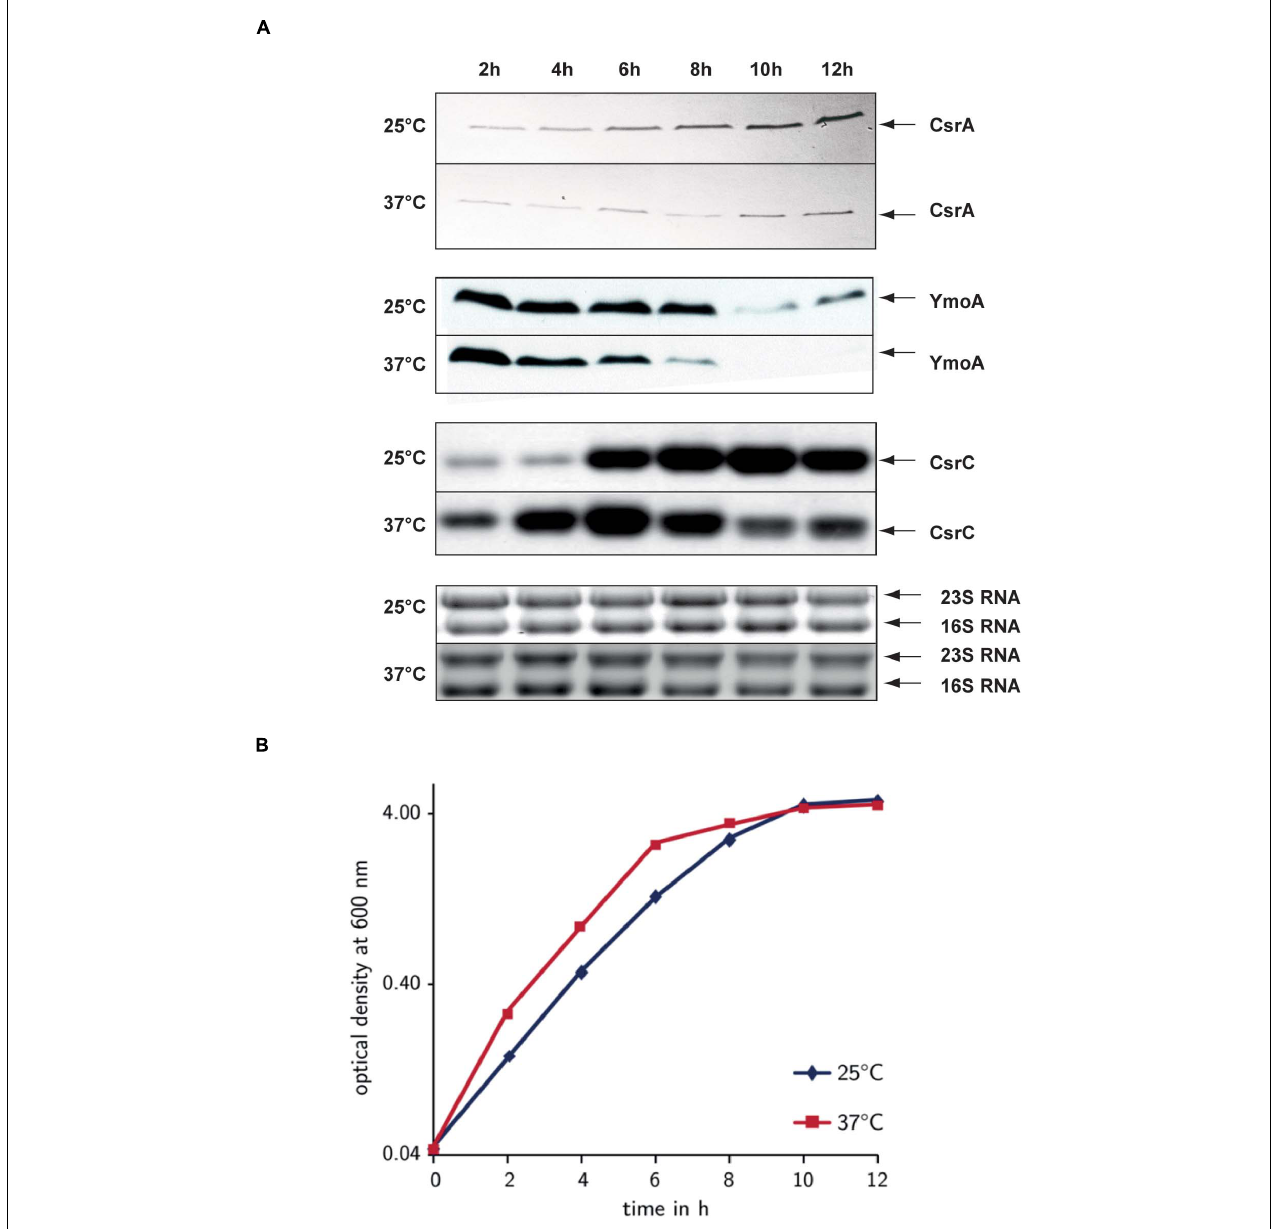
FIGURE 8 | Comparison of the environmental control of CsrA, YmoA, and CsrC synthesis. Y. pseudotuberculosis strain YPIII was diluted 1:100 from an overnight culture and was grown in LB at 25 and 37 ◦ C. Every 2 h, samples were withdrawn for whole cell extract and total RNA preparations (A) and the OD 600 of the cultures was determined to monitor growth (B) . (A) Total RNA of the samples was separated on agarose gels and the CsrC RNA was detected by Northern blotting using a CsrC-specific probe. Whole cell extracts were separated on 18% TRICINE polyacrylamide gels and analyzed by Western blotting with a polyclonal antibody directed against YmoA and CsrA. The CsrC RNA band and the YmoA and CsrA protein bands are indicated by arrows. (B) OD 600 of the cultures used for the upper analysis was plotted over time to illustrate and compare the different growth phases.